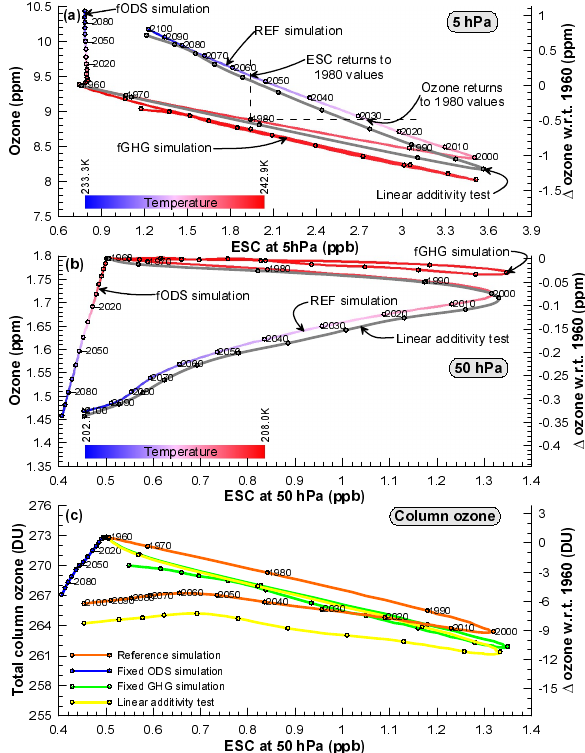
Fig. 4. (a) Annual multi-model mean tropical ozone as a function of ESC=Cl y +5 × Br y at 5hPa and averaged between 25 ◦ S and 25 ◦ N. (b) as in panel (a) but at 50hPa and where ESC=Cl y +60 × Br y . In panels (a) and (b) the REF-B2, fODS, and fGHG simulations are shown using traces colored according to the multi-model-mean temperature using the scale shown in the bottom left of each panel. The grey traces in these two panels show the additive effects of the fODS and fGHG simulations calculated from: Grey ESC (t) =fGHG ESC (t) + fODS ESC (t) − fODS ESC (1960) and Grey ozone (t) = fGHG ozone (t) + fODS ozone (t) − fODS ozone (1960). Differences between the grey and REF-B2 traces indicate a lack of linear additivity in the system. Panel (c) , as in (b) but for total column ozone and without color coding by tempera- ture. In this panel the fODS+fGHG trace is shown in yellow (yellow=blue+green). In all three panels, on each trace, reference years are shown every 10th data point with year labels shown for the REF-B2 simulation. The multi-model means displayed in this figure were derived from a subset of the 5 models that provided both fGHG and fODS simulations (see text for details).